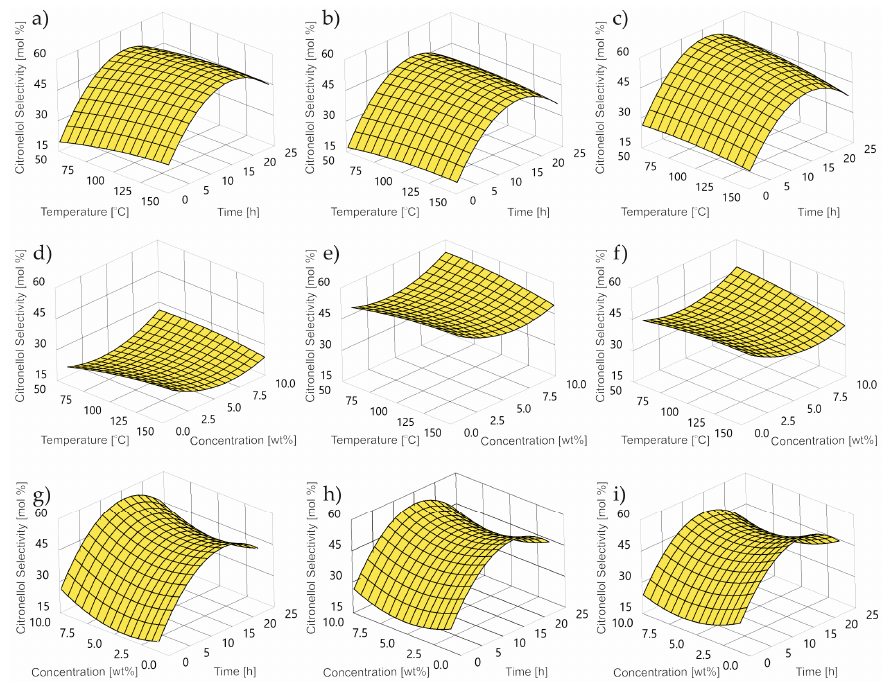
Figure 8a–i demonstrates the impact of the control factors into the value of the CL selectivity level.